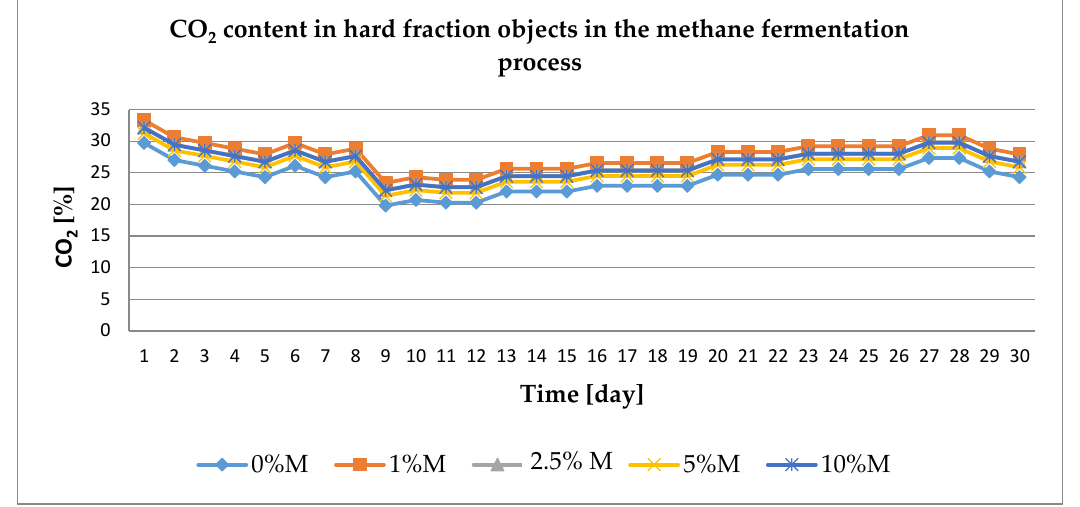
Figure 5. Carbon dioxide content in soft fraction objects in the methane fermentation process.